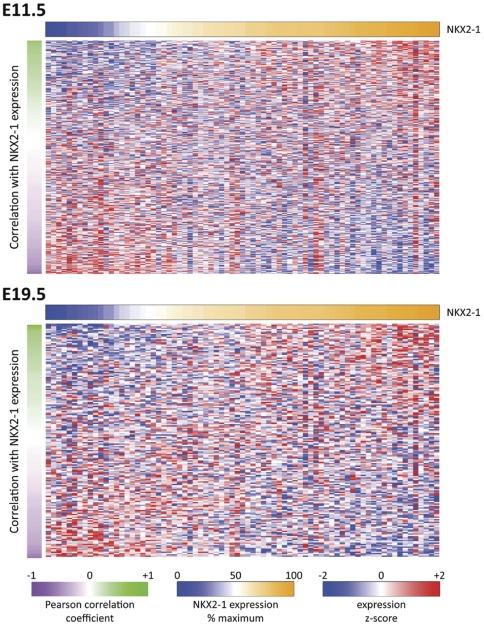
NKX2-1 levels in human lung tumors significantly correlate with expression of developmental Nkx2-1 target genes.Heatmaps of human lung tumor genes identified in GSE12667 database showing gene expression levels of the human homologues of Nkx2-1 target genes identified in mouse lung development at E11.5 (upper panel) and E19.5 (lower panel); genes are organized according to their Pearson correlation value (y axis) to relative NKX2-1 expression level (x axis).